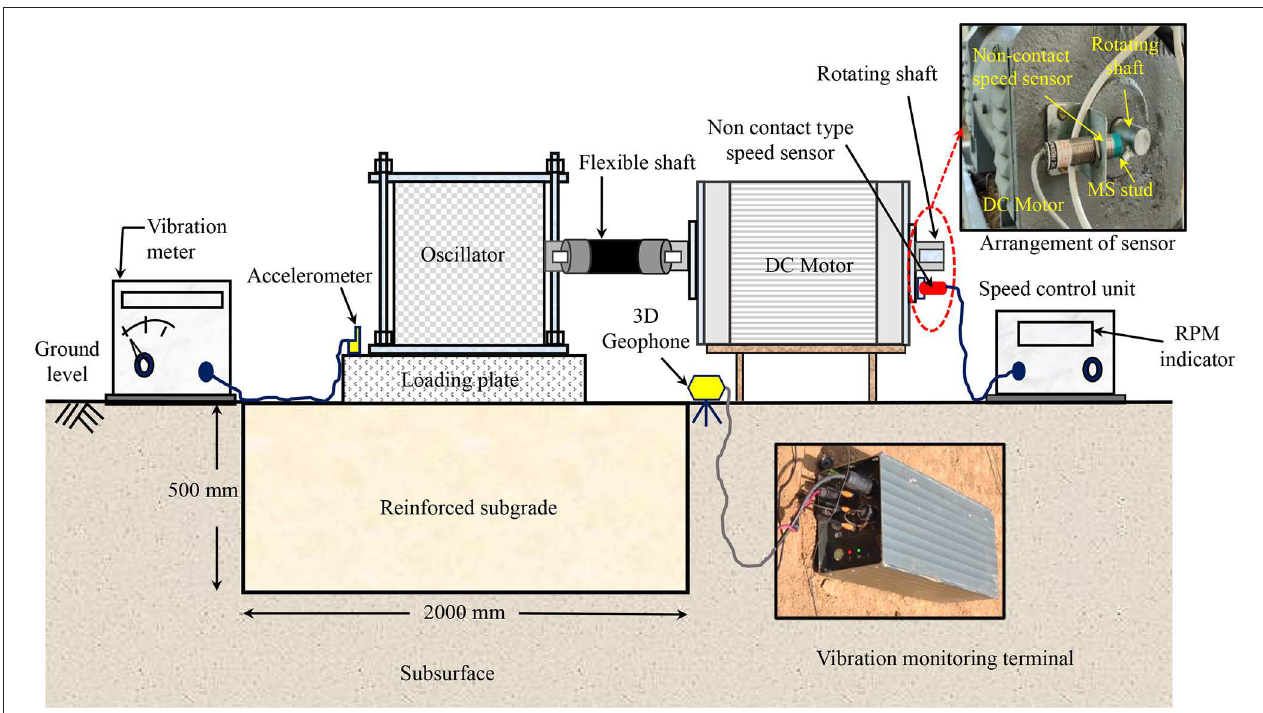
FIGURE 2 | Arrangement of the test